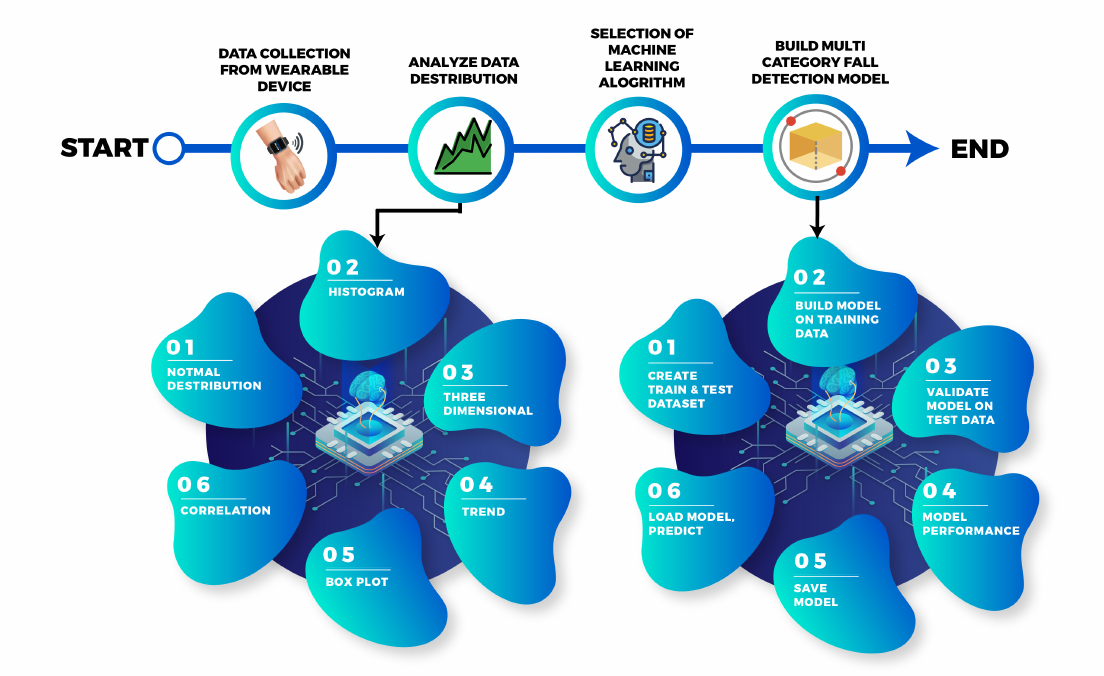
Figure 2. Flow chart of the proposed fall detection system.